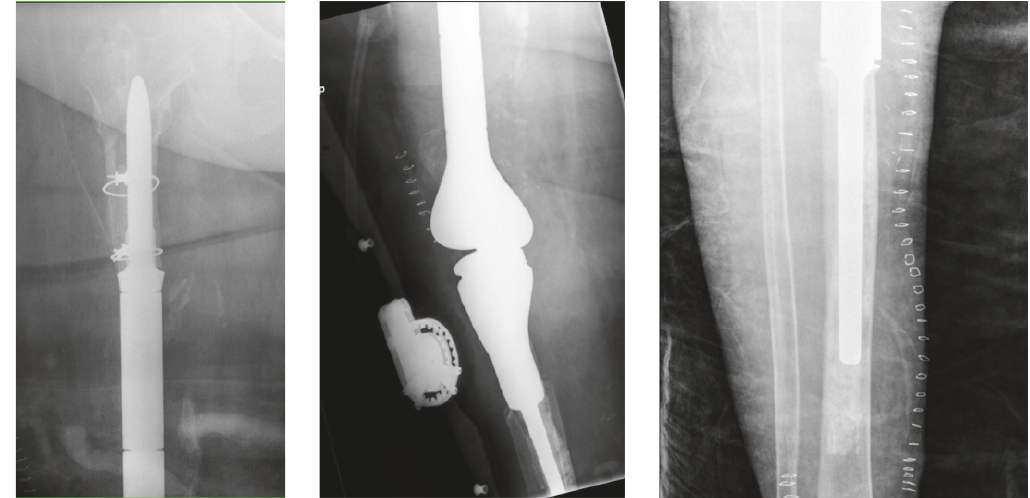
Figure 11: Postoperative radiographs of large endoprosthesis